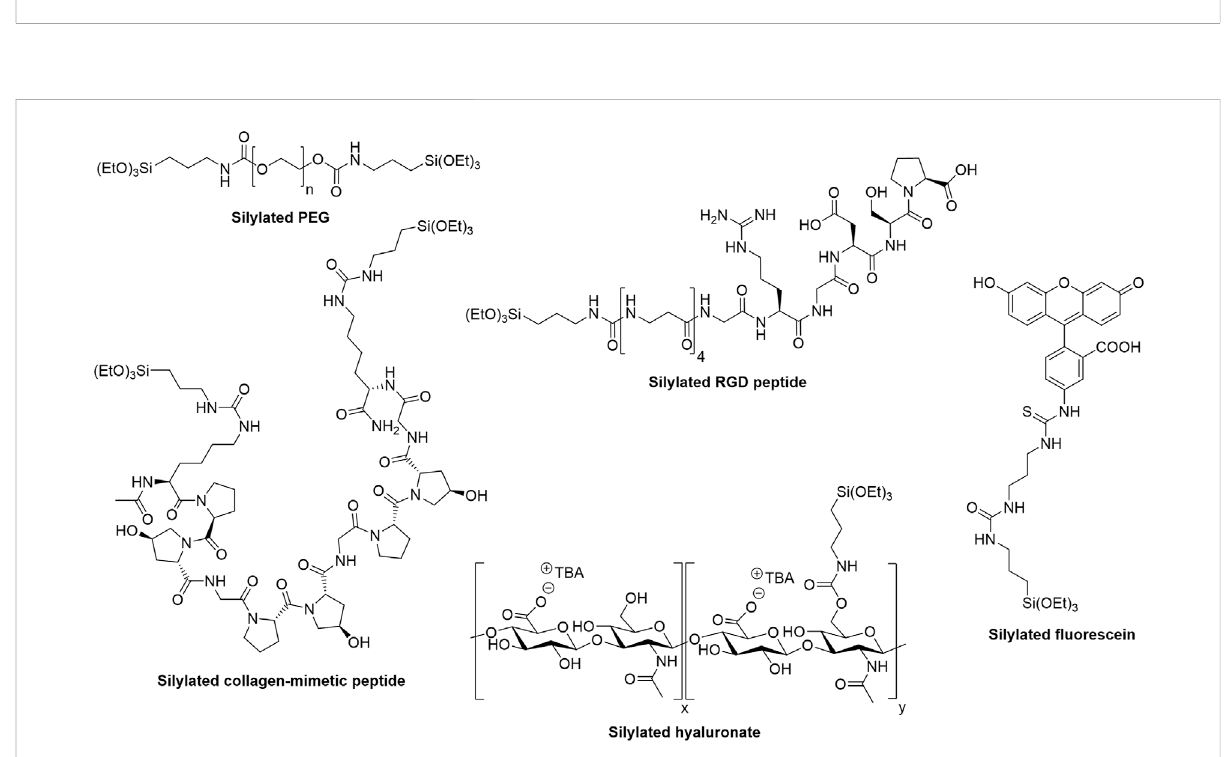
FIGURE 4 Examples of hybrid precursors that can be used to form and/or functionalize hybrid hydrogels via the sol-gel process.